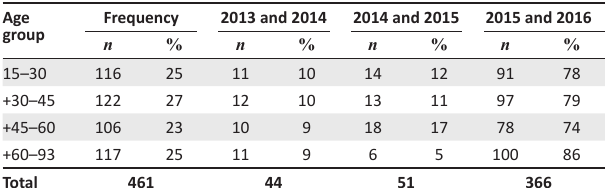
TABLE 5: Nursing-related morbidity by age group.